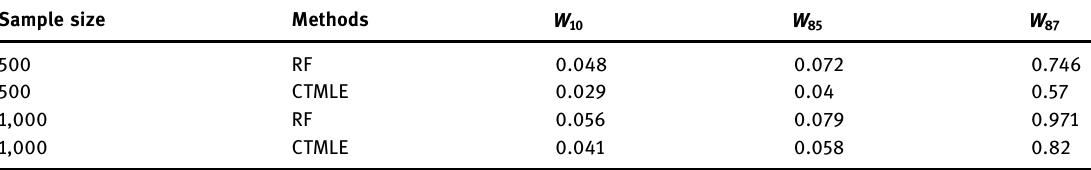
Table 3: Proportion of null hypotheses rejected using a random forest ( RF )- based test and the proposed CTMLE - based test Sample